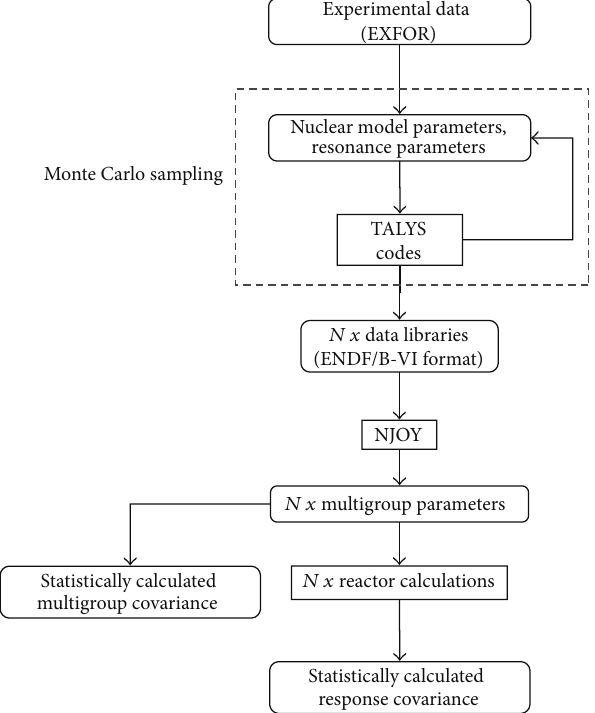
Figure 4: Simplified total Monte Carlo flowchart.